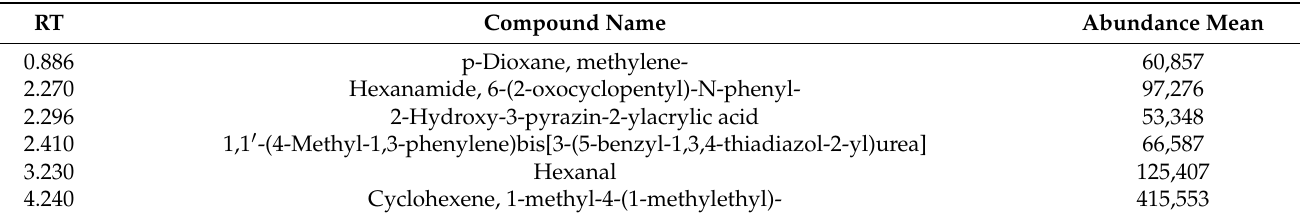
Table A7. Results for the EBL sample fingerprint determination with indication of the retention time (RT) and abundance mean for every identified